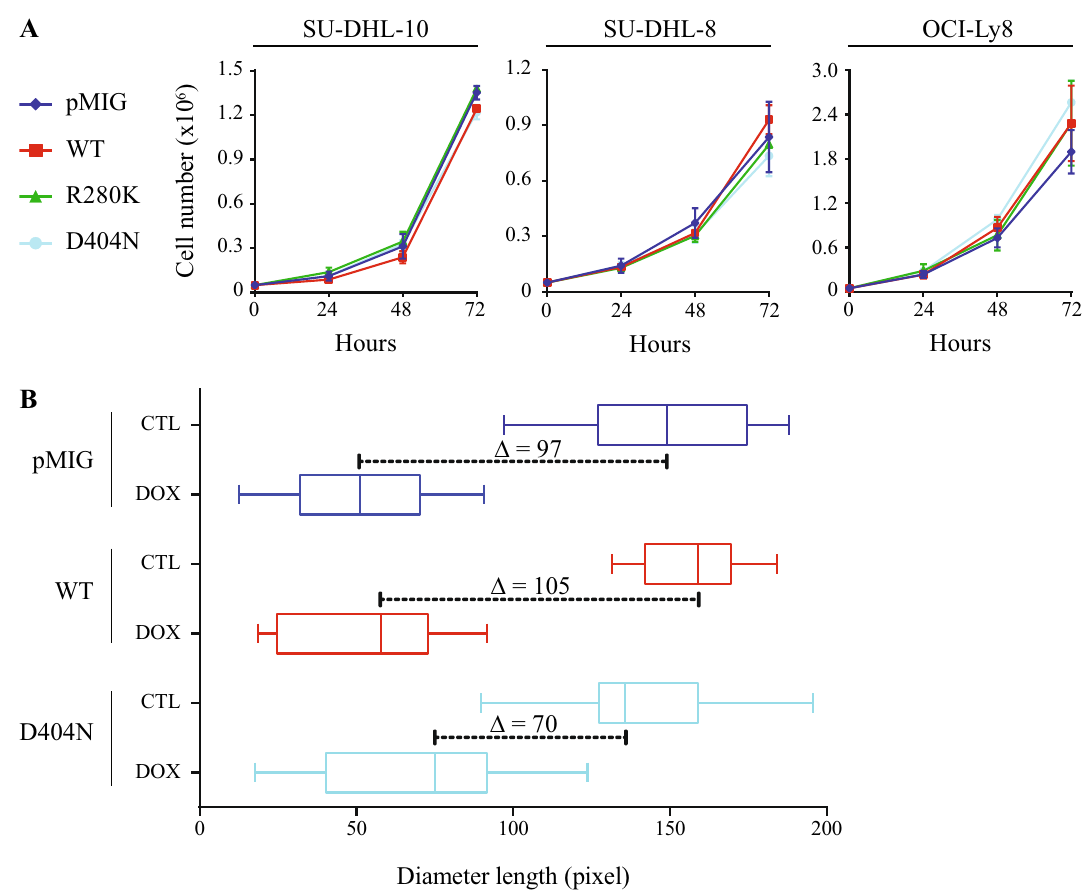
Figure 5. ( A ) Growth curves of stable cell lines show no difference between mutant and wild-type RASGRP4 GCB-DLBCL cell lines. Viable cell number was assessed by trypan blue staining over 3 days in culture. ( B ) SU-DHL-8 cells overexpressing mutant RASGRP4 D404N are more resistant than RASGRP4 WT cells or parental cells expressing empty vector when treated with 2.5 ng/mL doxorubicin for 12 days. A representative plot of one biological replicate is